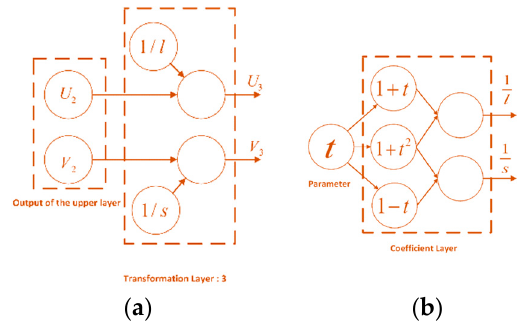
Figure 6. Structures of the transformation layers. ( a ) Third layer; ( b ) coefficient layer.